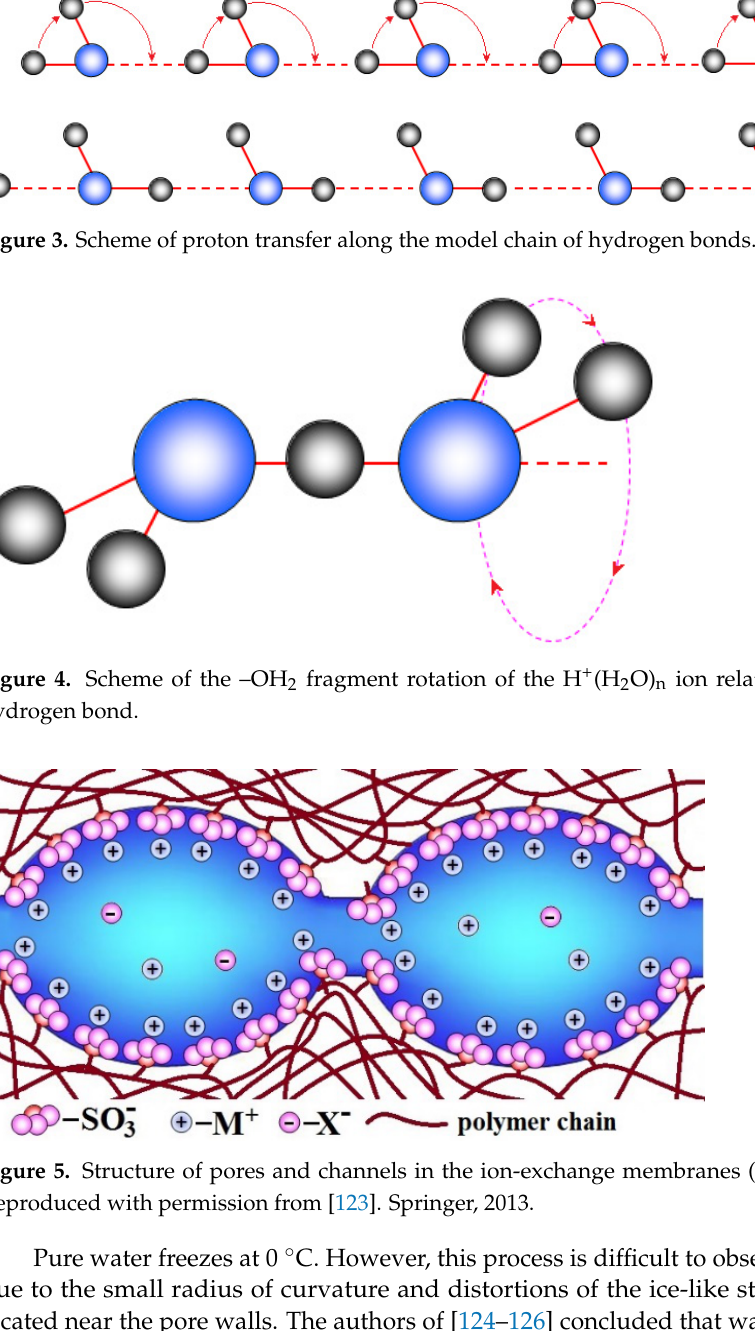
Figure 4. Scheme of the –OH 2 fragment rotation of the H + (H 2 O) n ion relative to the strongest hy- drogen bond.